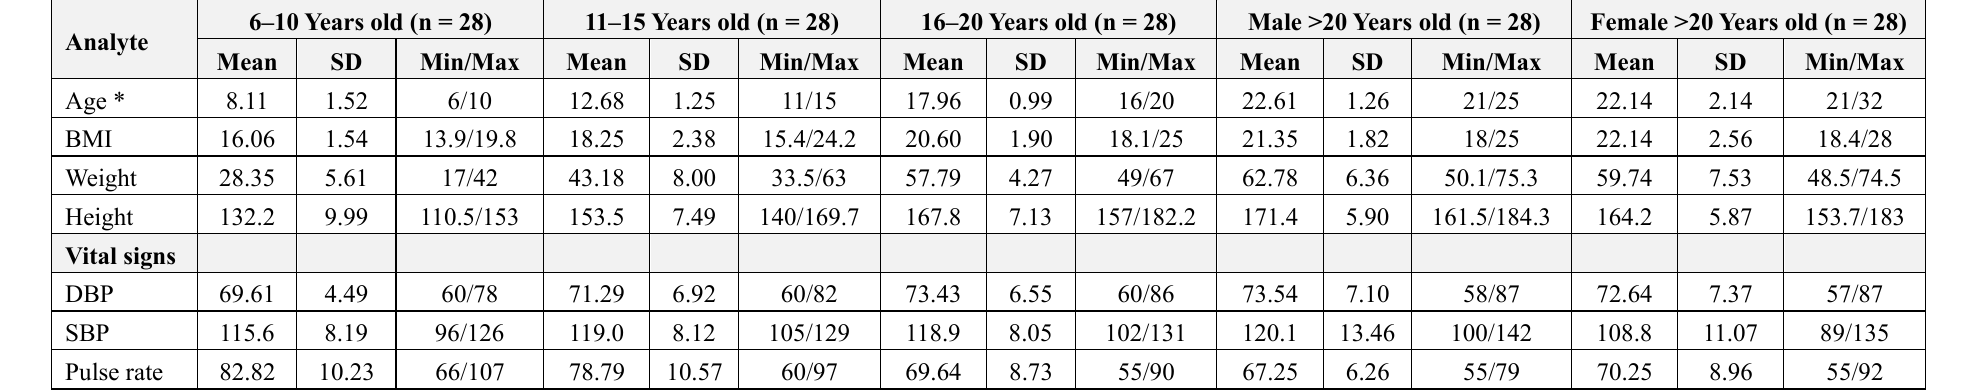
Table 1. Study population characteristics in different age groups (n =